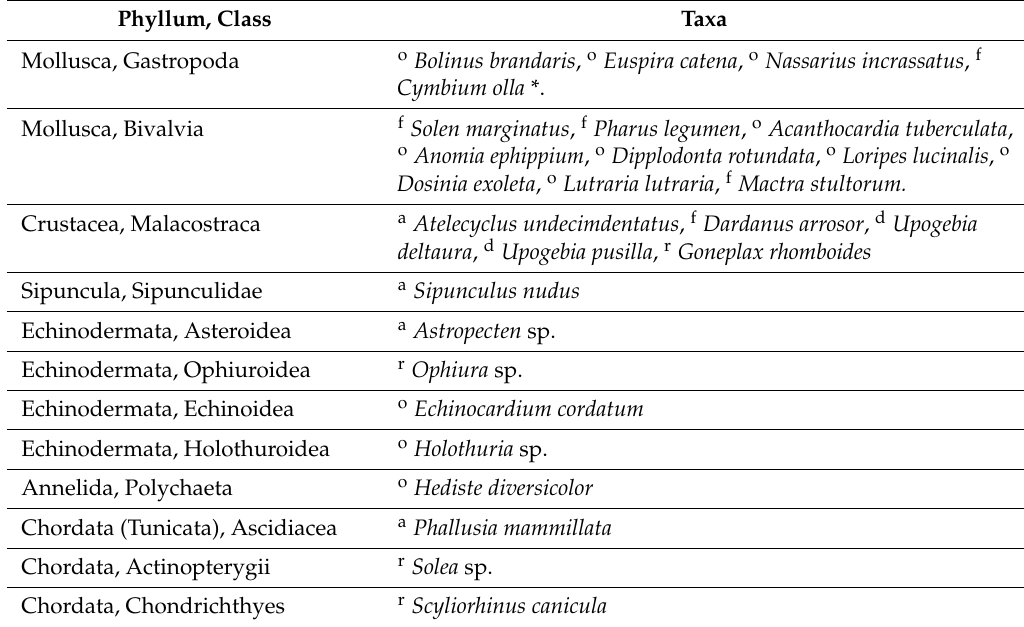
Table 1. Organisms stranded on the beach during the massive stranding occurred during March 4–8, 2018. The symbols indicate a semiquantitative category of relative abundance: Rare (r), occasional (o), frequent (f), abundant (a), and dominant